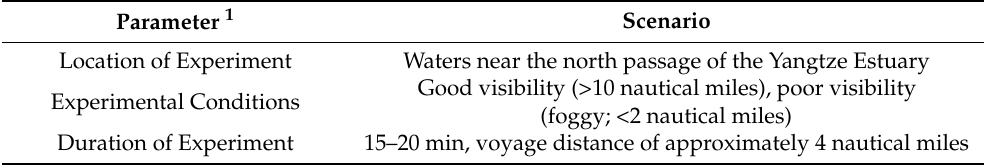
Table 3. Simulation overview.